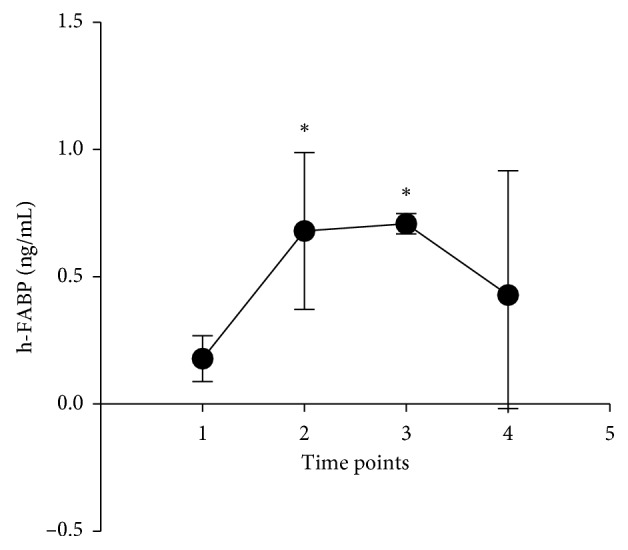
Levels of h-FABP at different time points for the control group. 1, pre-PCI right time; 2, 3 h post-PCI; 3, 6 h post-PCI; 4, >10 h post-PCI; ∗P < 0.05.